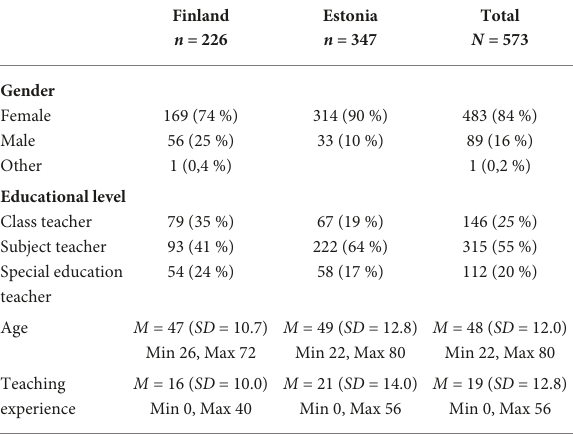
TABLE 1 Finnish and Estonian teachers’ background